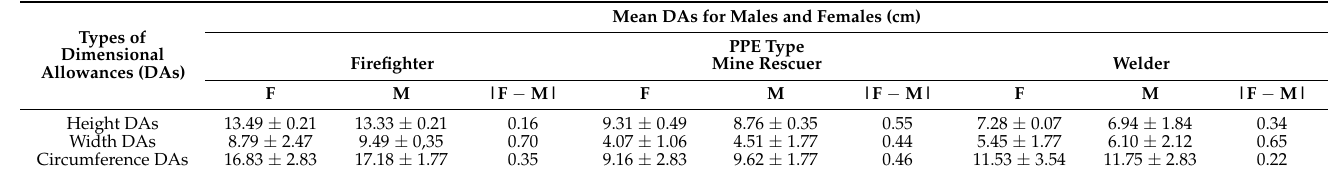
Table 2. Mean height, width, and circumference dimensional allowances (DAs) for male (M) and female (F) firefighters, mine rescuers, and welders wearing personal protective equipment.